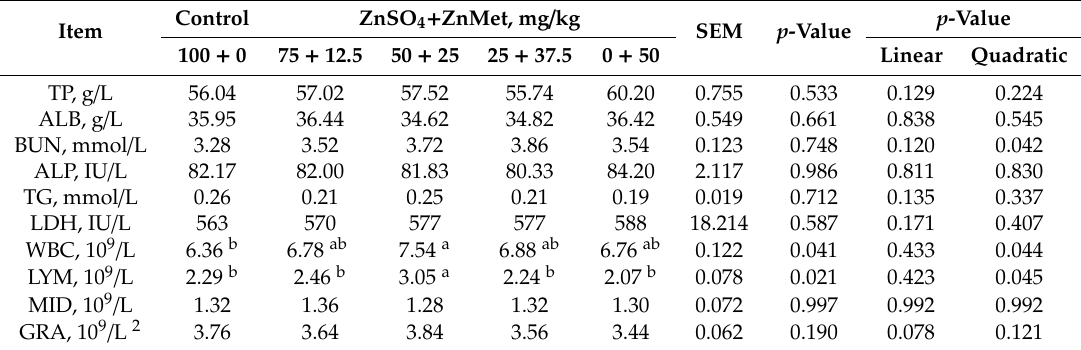
Table 4. E ff ects of dietary substitution of ZnSO 4 by low levels of ZnMet on serum metabolites and hematological indices of 37- to -79-d-old piglets 1.